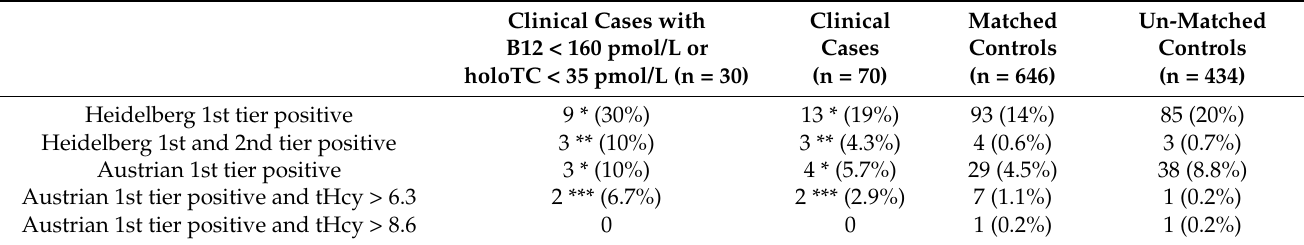
Table 4. Results from applying B12 deficiency algorithms according to the Austrian and Heidelberg NBS for cases and controls (n, %). Clinical Cases with